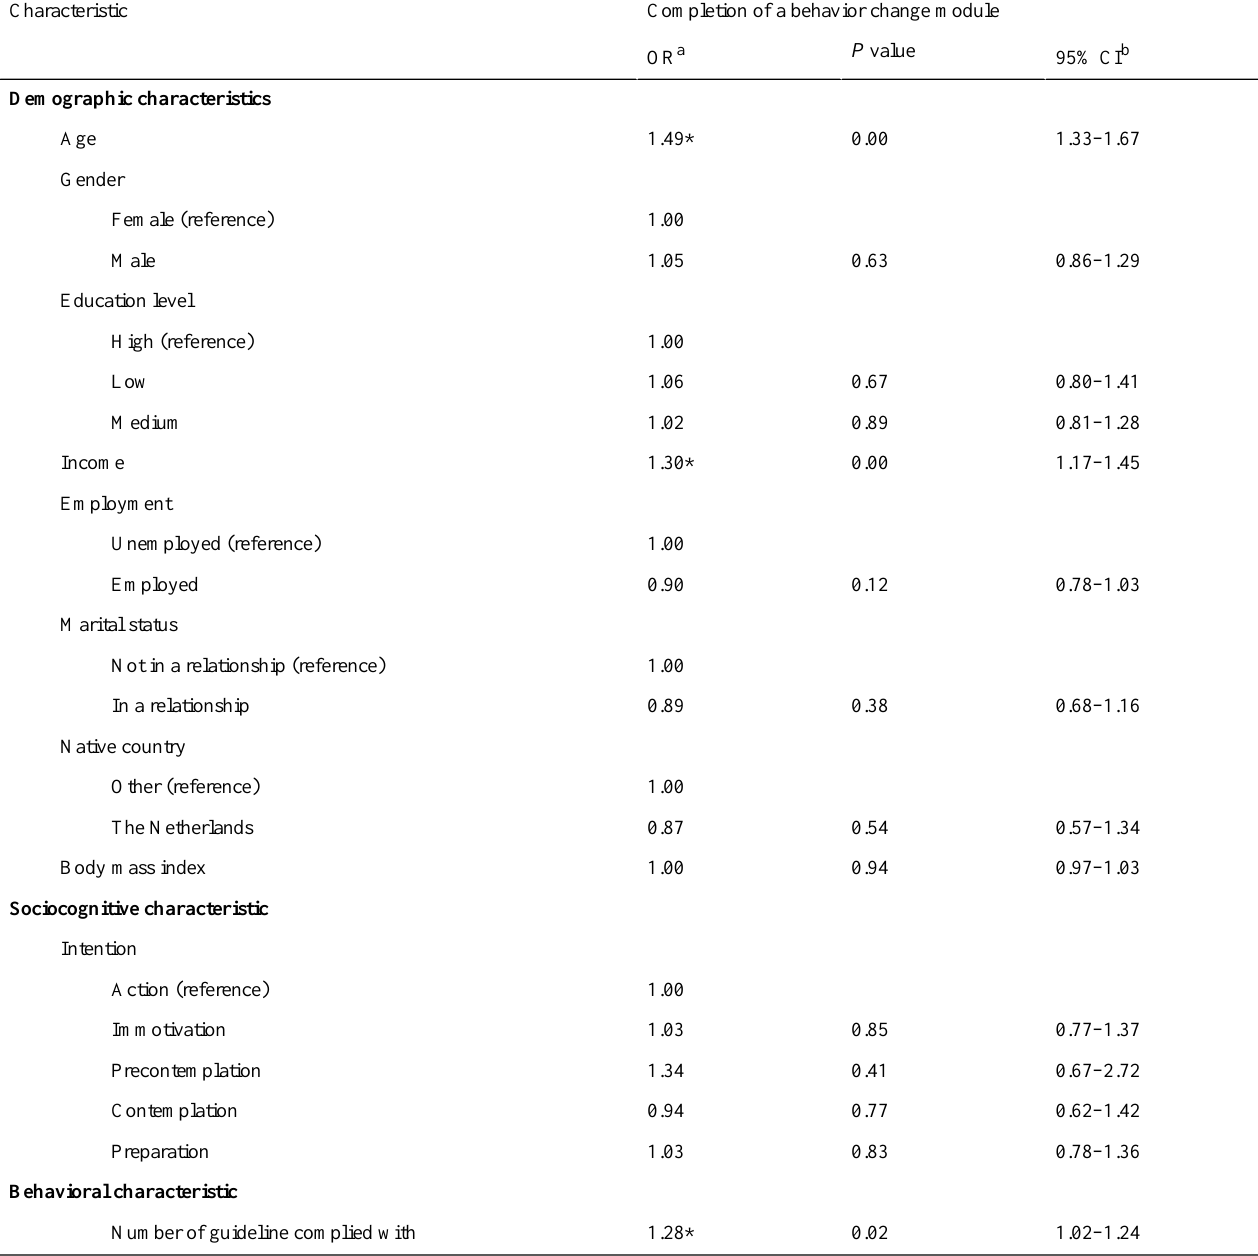
Table 3. Results of multivariate logistic regression analyses of demographic characteristics, behavioral characteristic, and intention, with completion of a behavioral computer-tailored module as dependent variable (n =